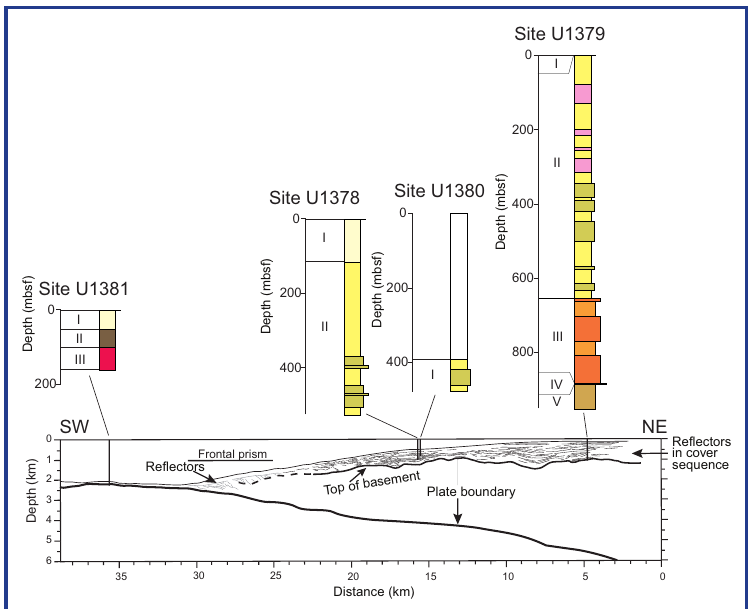
Figure 4. Lithostratigraphic columns from Exp. 334 sites. At Site U1378 Unit I is formed by clay, silt, and sand, Unit II by clay(stone), silt(stone), and sandstone. At Site U1379, Unit I is formed by coarse sand, Unit II by clay(stone), silt(stone), and sandstone, Unit III by fine to medium sandstone, Unit IV by medium to coarse sand, and Unit V by breccia. At Site U1380, Unit I is formed by clay(stone), silt(stone), and sandstone. At Site U1381, Unit I is formed by clay and silty clay, Unit II by siliceous to calcareous ooze, and Unit II by